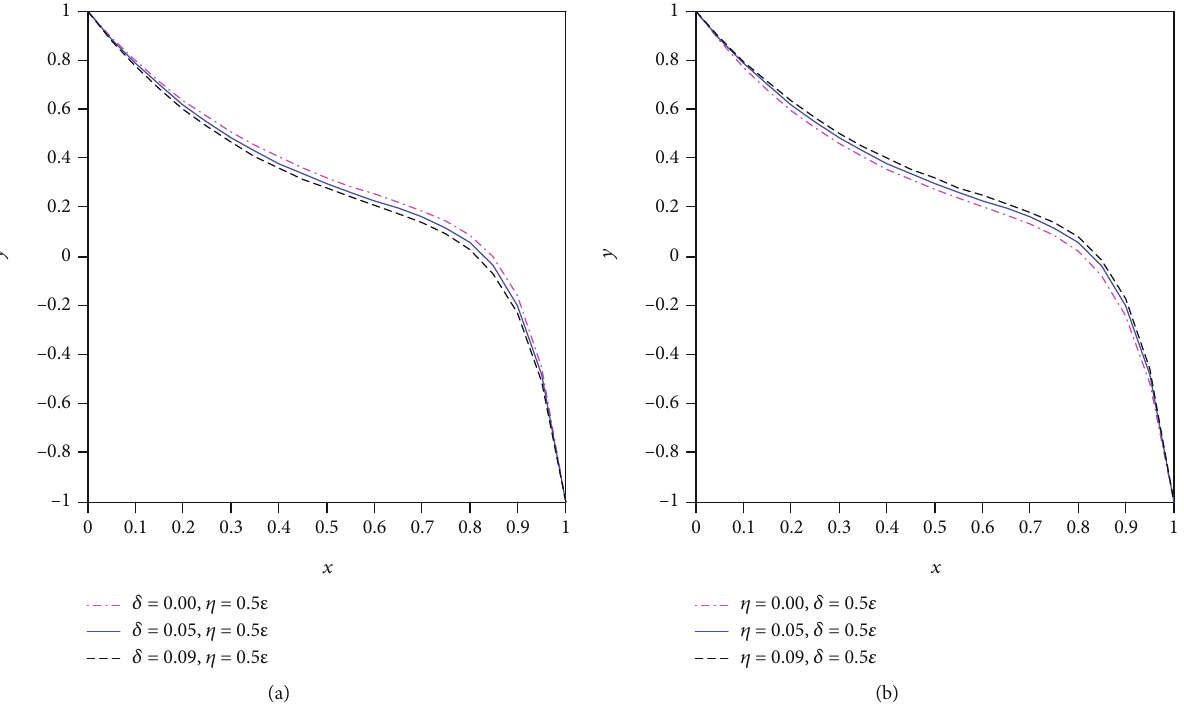
Figure 1: Numerical solution of Example 5 for ε = 0 : 1 and N = 20 .